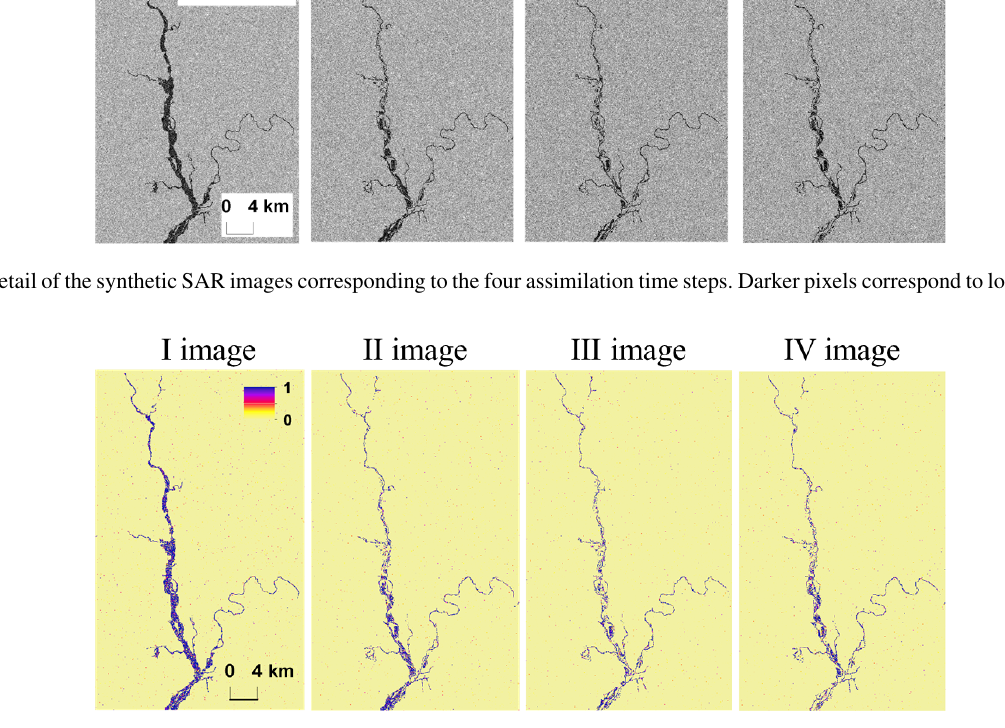
Figure 4. Details of the synthetic probabilistic flood maps are derived from synthetic SAR images. The probabilities of being flooded given the SAR backscatter values go from low values (yellow) to high values (blue). Table 1. Critical success index values at each assimilation time step. The open loop (Fig. 6) where no assimilation is computed is compared with the standard method and the adapted method with an increasing effective ensemble size (EES).